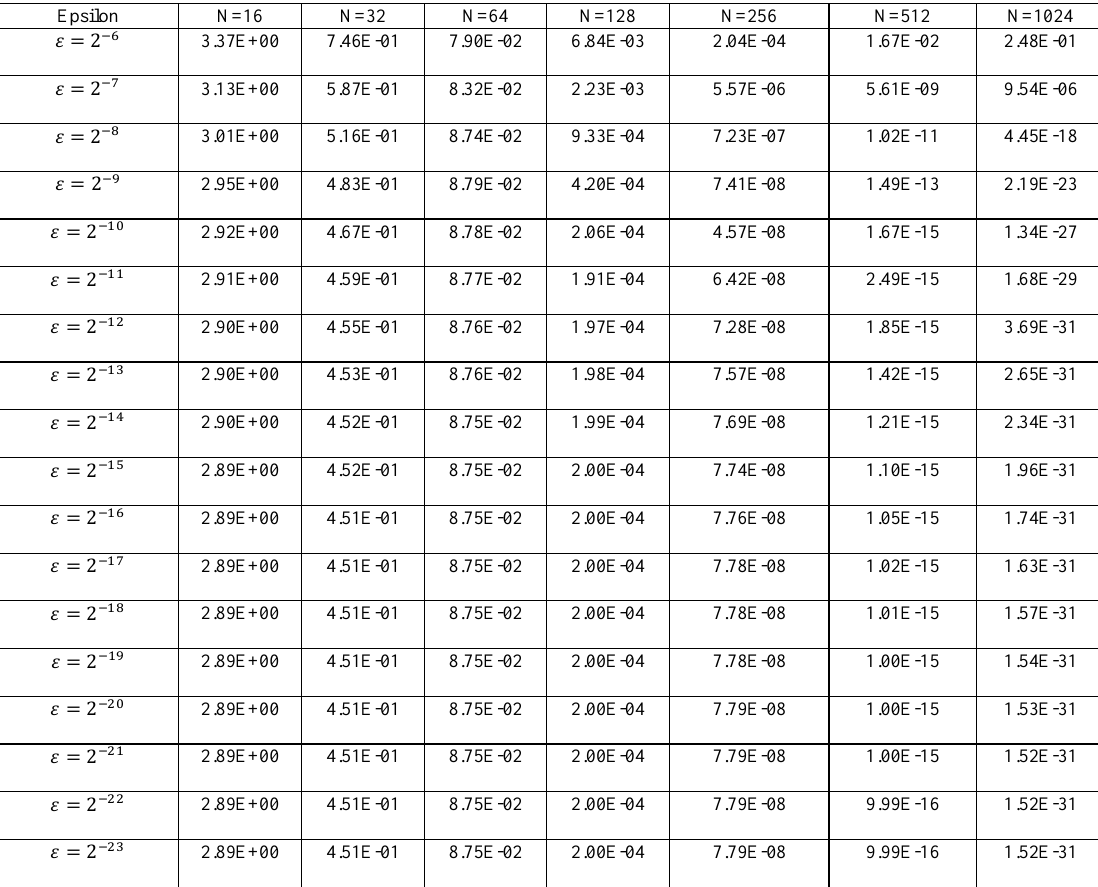
Table 2. Maximum absolute error of Example